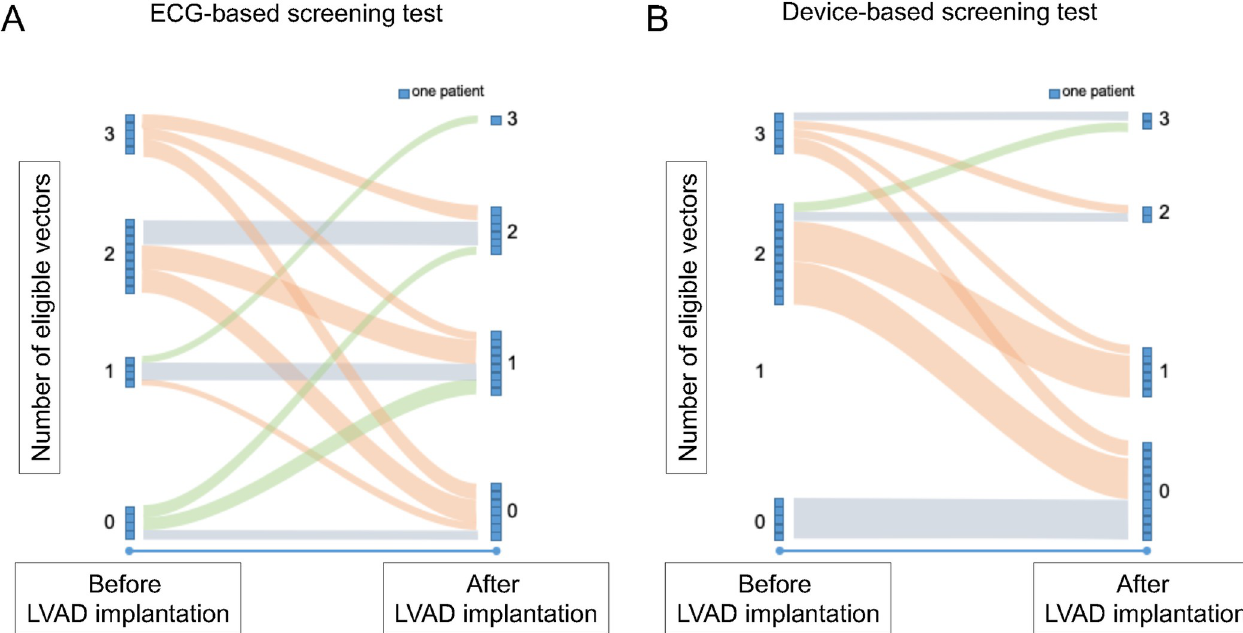
Fig 2. Sankey plot showing the number of eligible vectors before and after LVAD implantation using the ECG-based (A) and the device-based (B) S-ICD screening test. LVAD = left ventricular assist device.